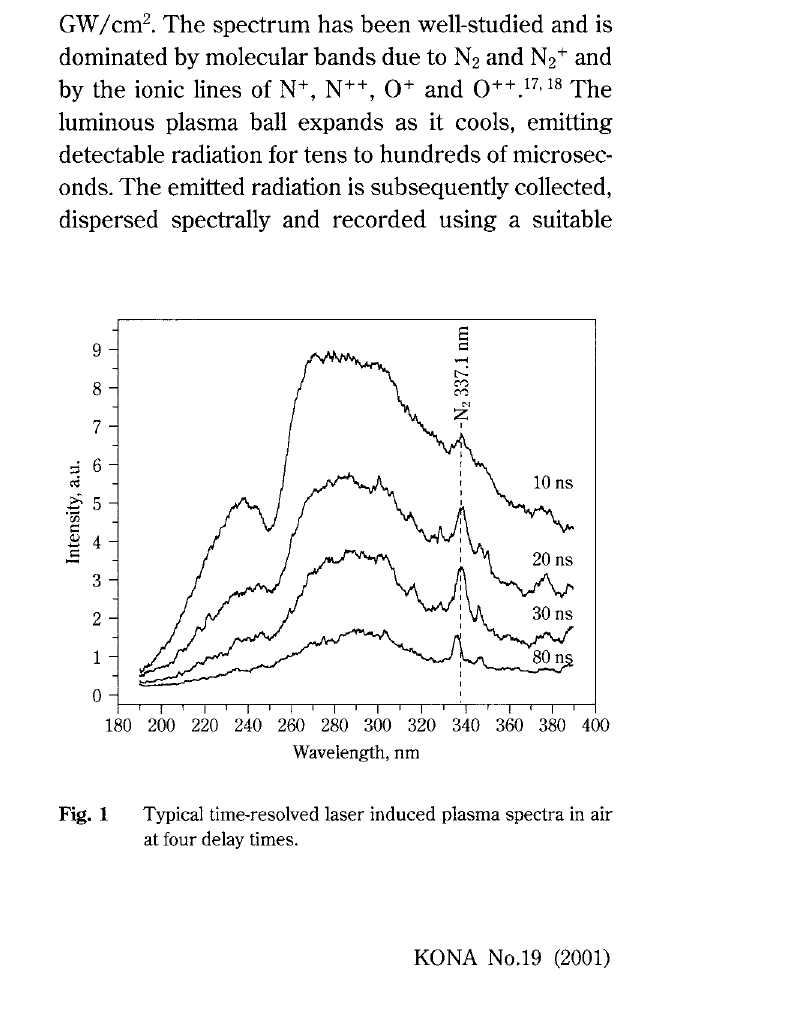
Fig. 1 Typical time-resolved laser induced plasma spectra in air at four delay